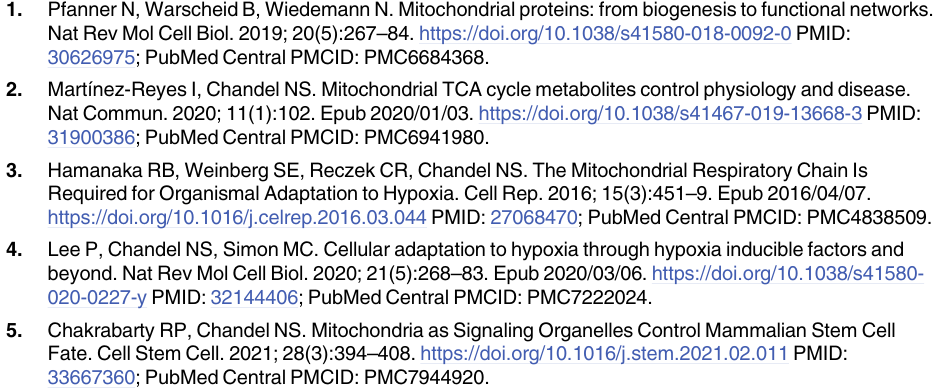
S1 Table. Primer sequences for relative mtDNA copy number analysis. S2 Table. Primer sequences for qRT-PCR